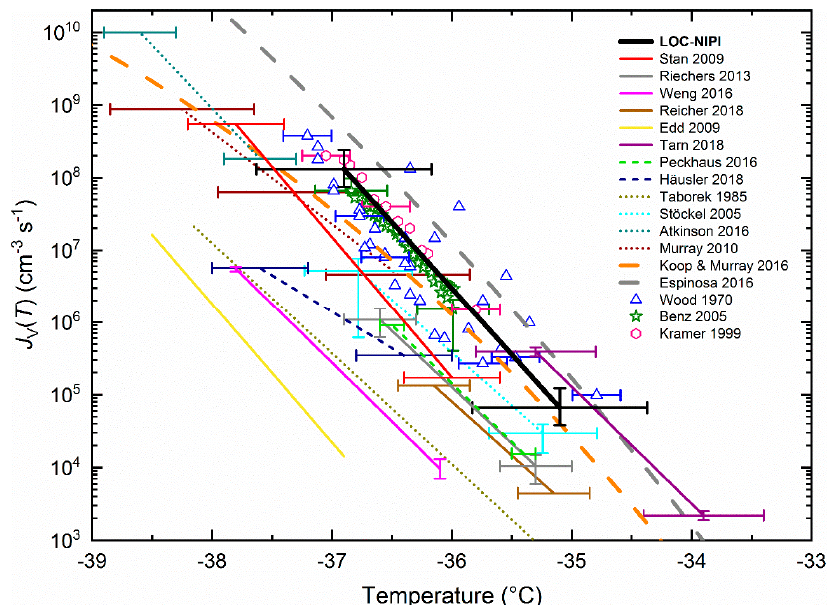
Figure 3. The volume nucleation rate coefficient, J V ( T ), values obtained using the LOC-NIPI, alongside data from microfluidic platforms in the literature (solid lines) [26–29,31–33,37]. Parameterisations calculated for Peckhaus et al. [31] and Häusler et al. [33] in this article are shown as dashed lines. A selection of non-microfluidic parameterisations [7,49,51,62] (shown as dotted lines) and datasets (shown as discrete points) [59–61] are also provided. The physically constrained CNT parameterisation of Koop and Murray [41] and a parameterisation based on the TIP4P/Ice model by Espinosa et al. [14,63] are shown as broadly dashed lines. Details of all of the microfluidic parameterisations can be found in Table 3.